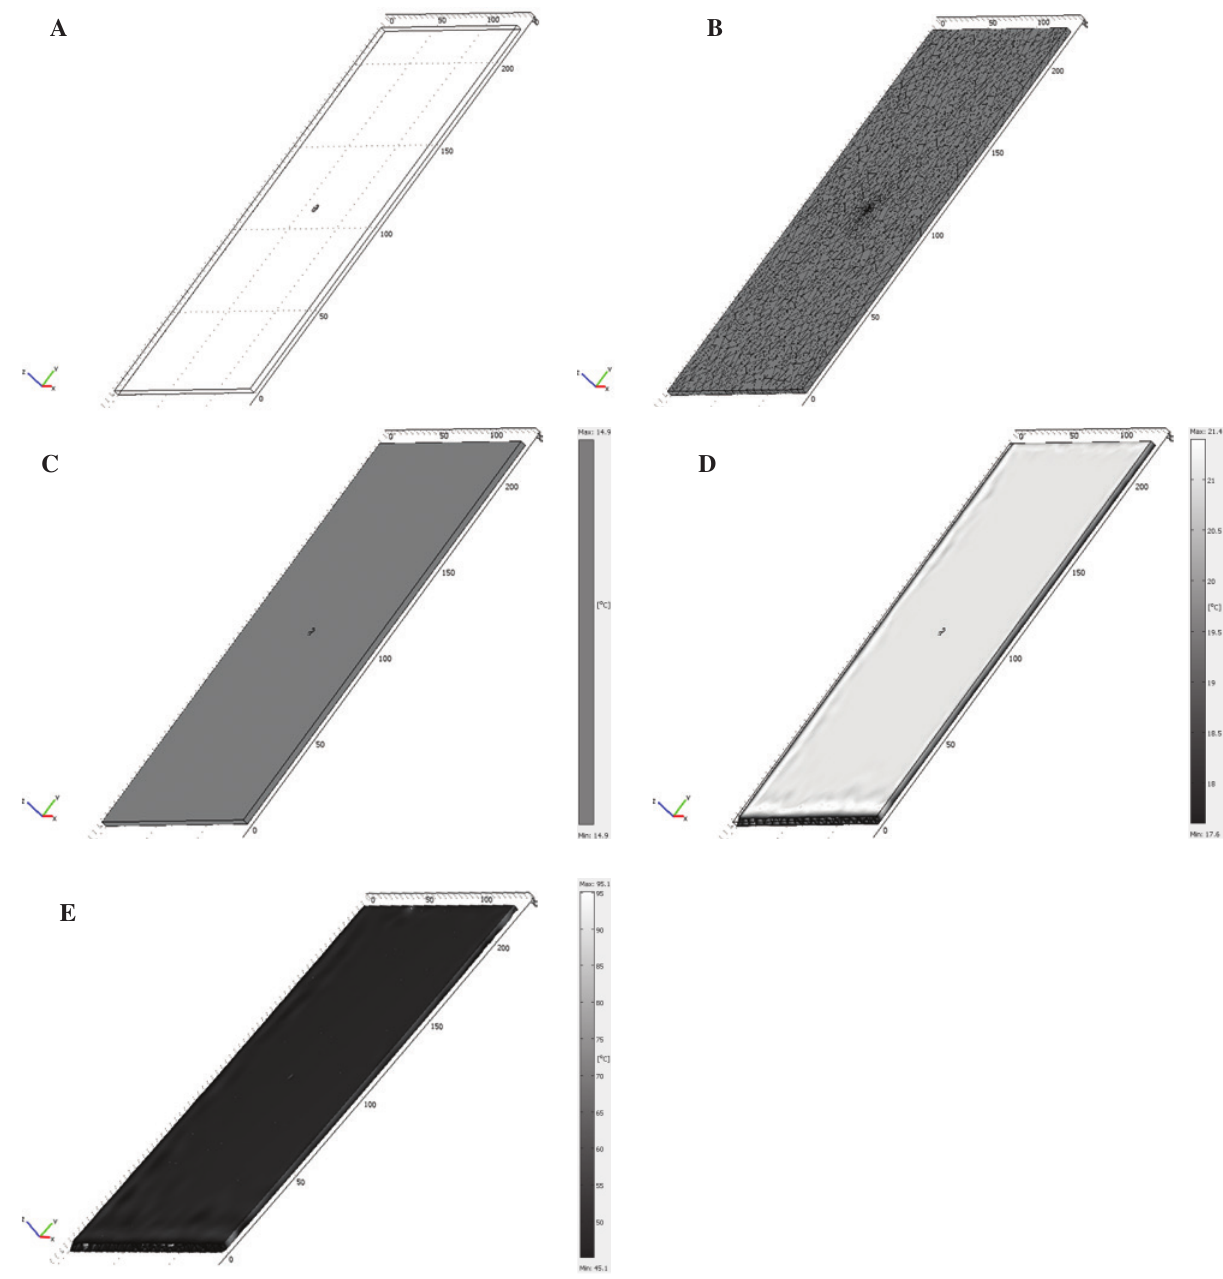
Figure 7 (A) Structure of the indented sample realized by COMSOL ® , (B) mesh, (C) temperature ( ° C) at the steady state, and square pulse (SP): (D) temperature distribution ( ° C) at 1 s, (E) temperature distribution ( ° C) at 240 s.